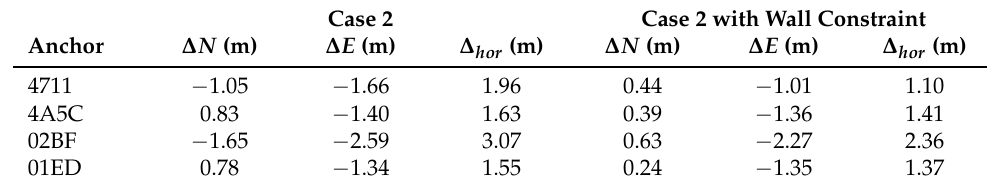
Table 5. Case 1: Error of the anchor position estimation based on test 5. Table 6. Case 2: error of the anchor position estimation based on Test 5.